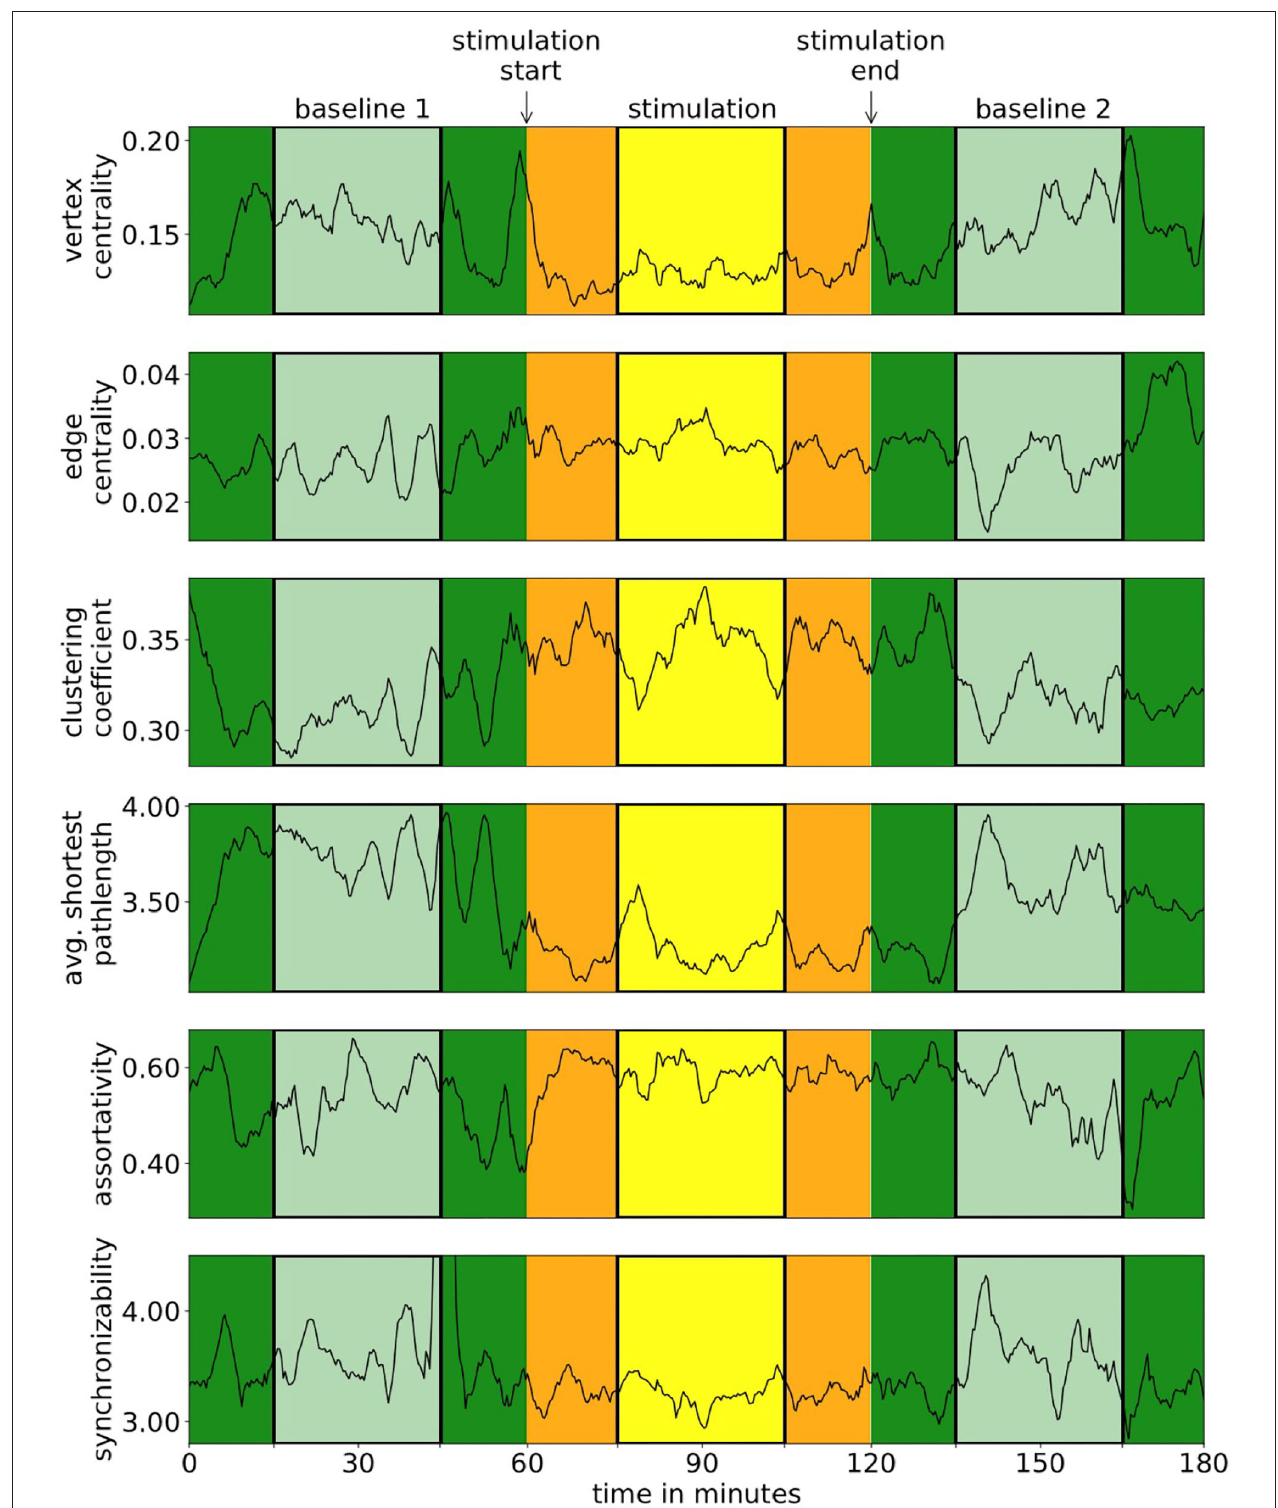
FIGURE 1 | Exemplary time courses of local and global network characteristics of one subject. In our analyses, we neglected data from the first and last 15min of each phase (darker colors) in order to remove possible transient effects.